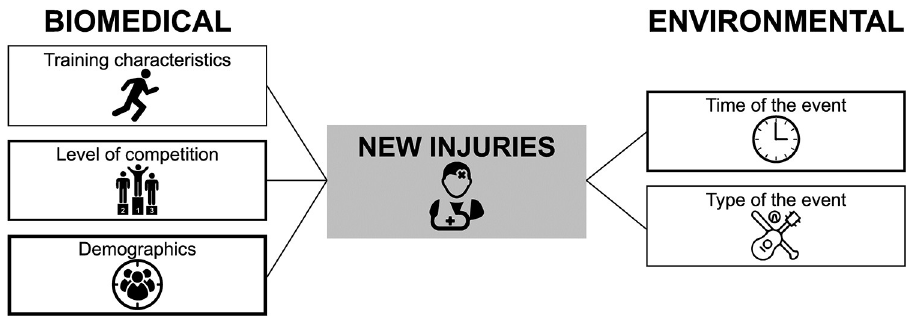
Fig 4. Biomedical and environmental variables from multivariable regression analyses predicting new injuries. The thickness of the box represents the number of multivariable models including the following predictors: training characteristics (n = 1, type of training, training frequency, type of terrain); level of competition (n = 2, running pace, running experience); demographics (n = 3, age, gender, BMI); time of the event (n = 2, season); type of the event (n = 1, sport events, carnival/fetes, music